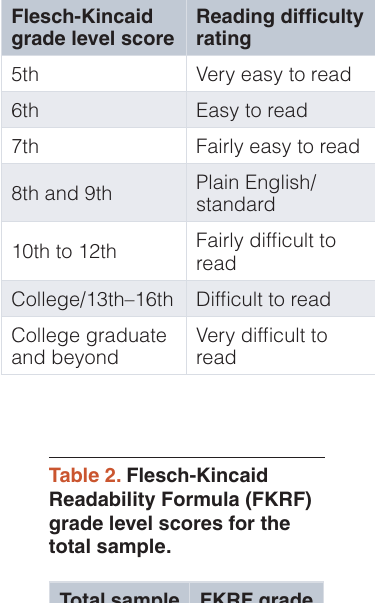
Table 1. Reading difficulty rating of Flesch-Kincaid Readability Formula grade level scores 8 .